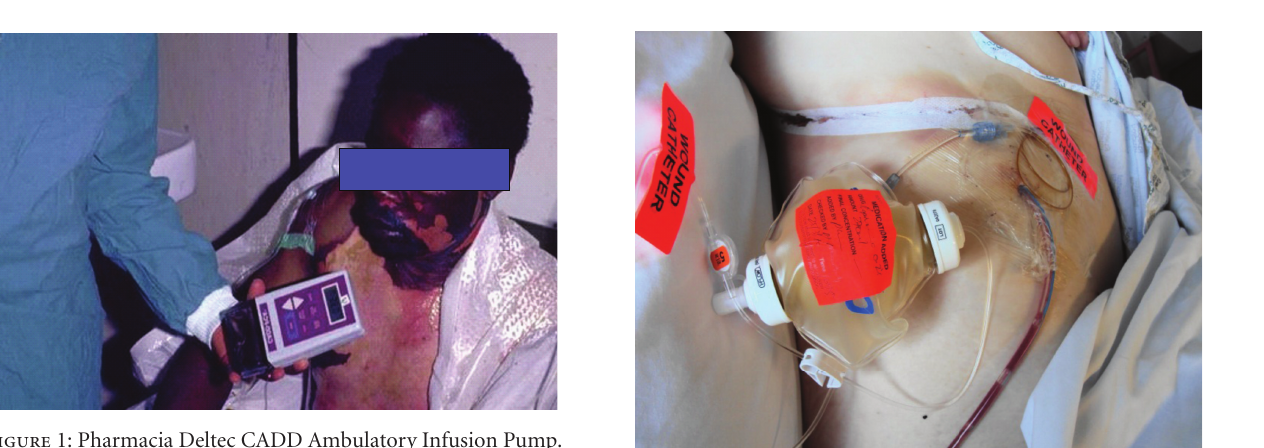
Figure 1: Pharmacia Deltec CADD Ambulatory Infusion Pump.